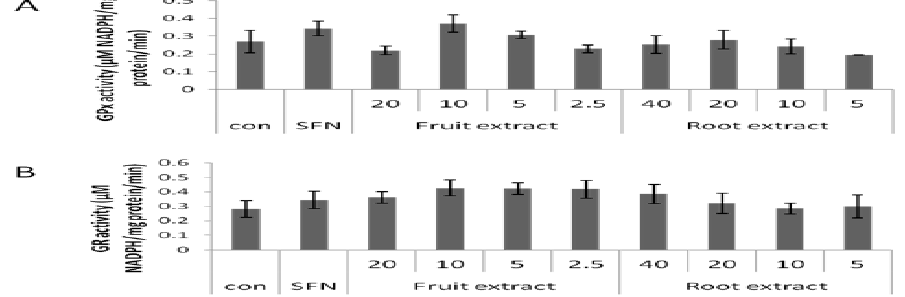
Fig. 4. Effect of the root and the fruit extracts on GPx and GR enzymes activity.